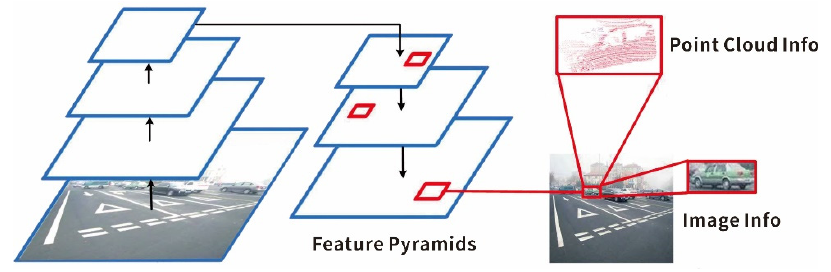
Figure 8. Feature pyramid network.